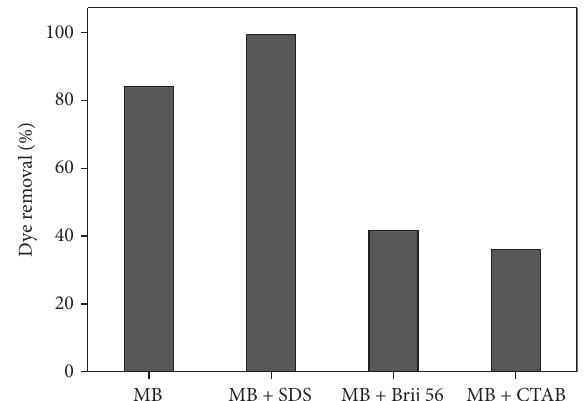
F 5: Effect of surfactants on MB adsorption